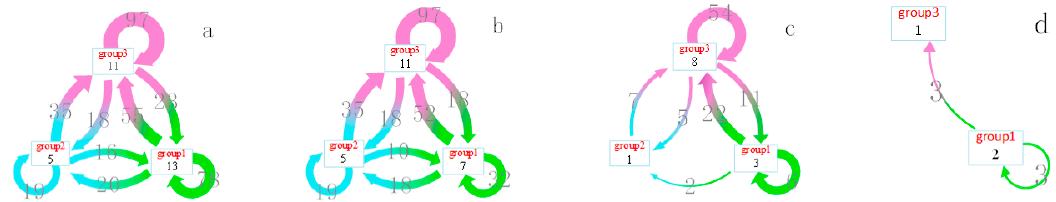
Figure 20. Interaction pattern representations of layer1 at di ff erent ranges of degree: ( a ) Degree ∈ [ 8,42 ] , ( b ) Degree ∈ [ 18,42 ] , ( c ) Degree ∈ [ 28,42 ] , ( d ) Degree ∈ [ 35,42 ]